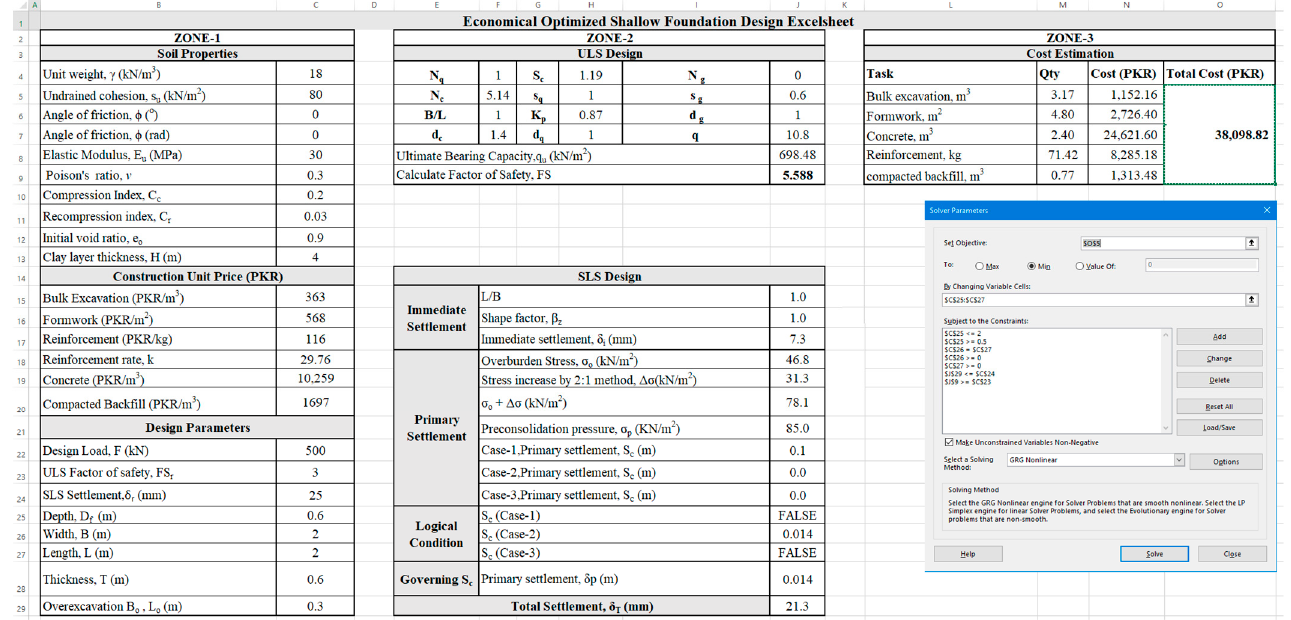
Figure A1. Cost-based optimization model for isolated foundations.